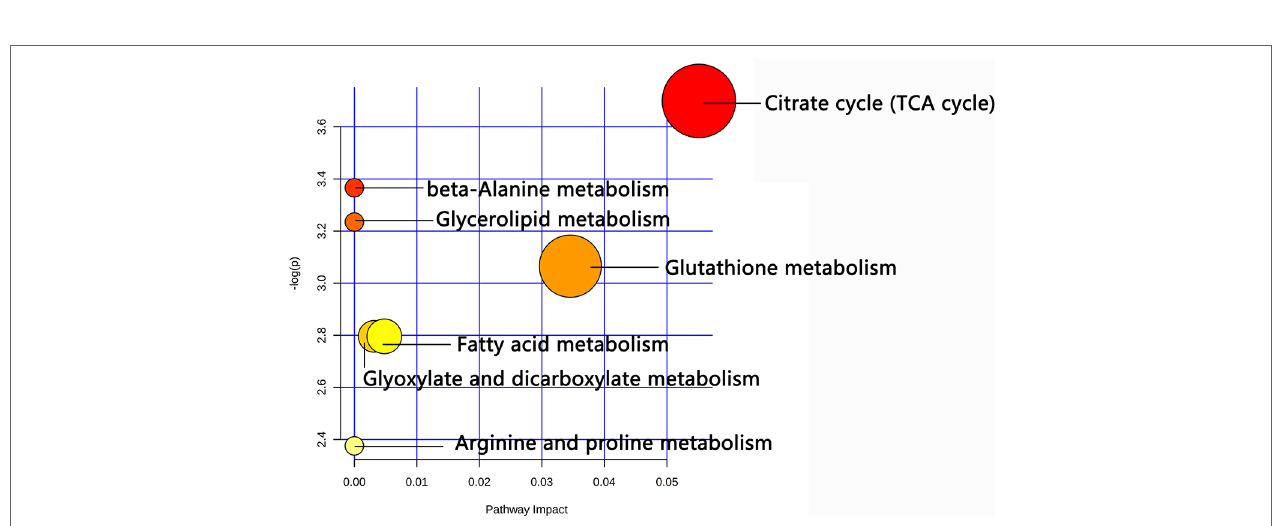
FIGURE 3 | The disturbed metabolic pathways showed differential metabolites changed in the Xuefu Zhuyu decoction group as compared with the placebo group by MetaboAnalyst 4.0 software. Node radius was based on pathway impact values. Node color was based on P